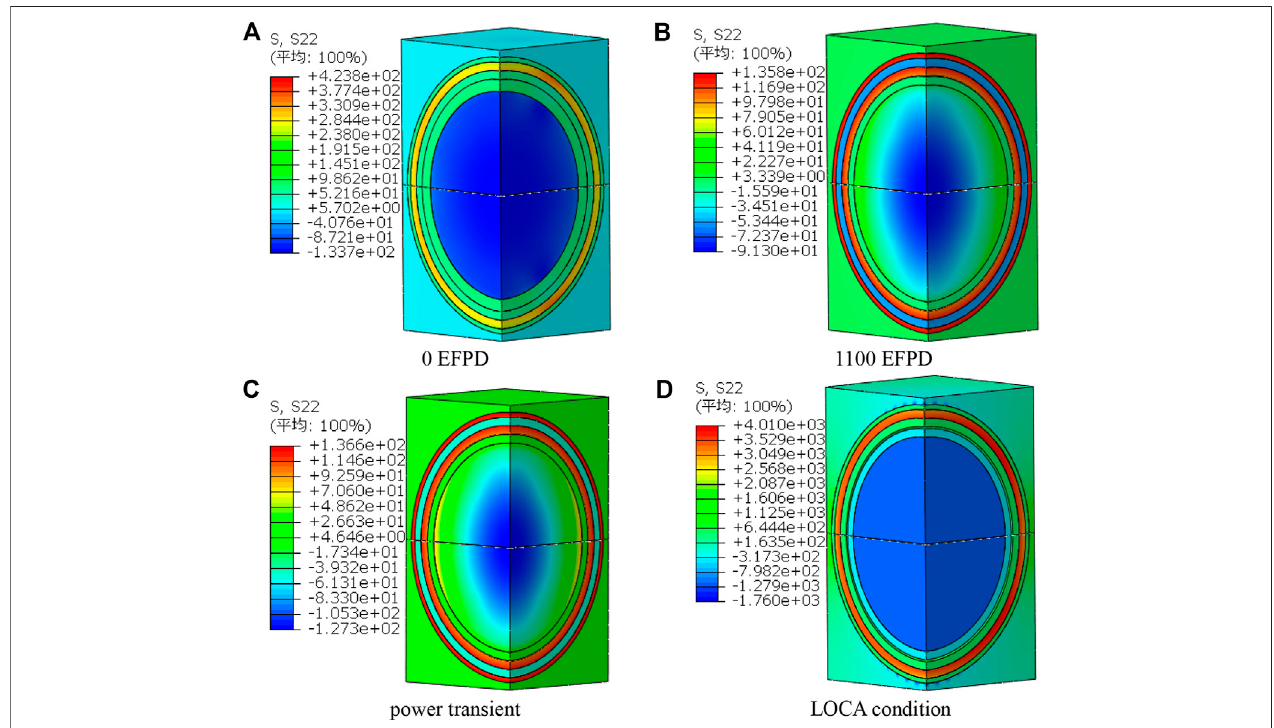
FIGURE 10 | hoop stress distribution contour of RVE model under different conditions. (A) 0 EFPD. (B) 1,100 EFPD. (C) Power transient. (D) LOCA condition.